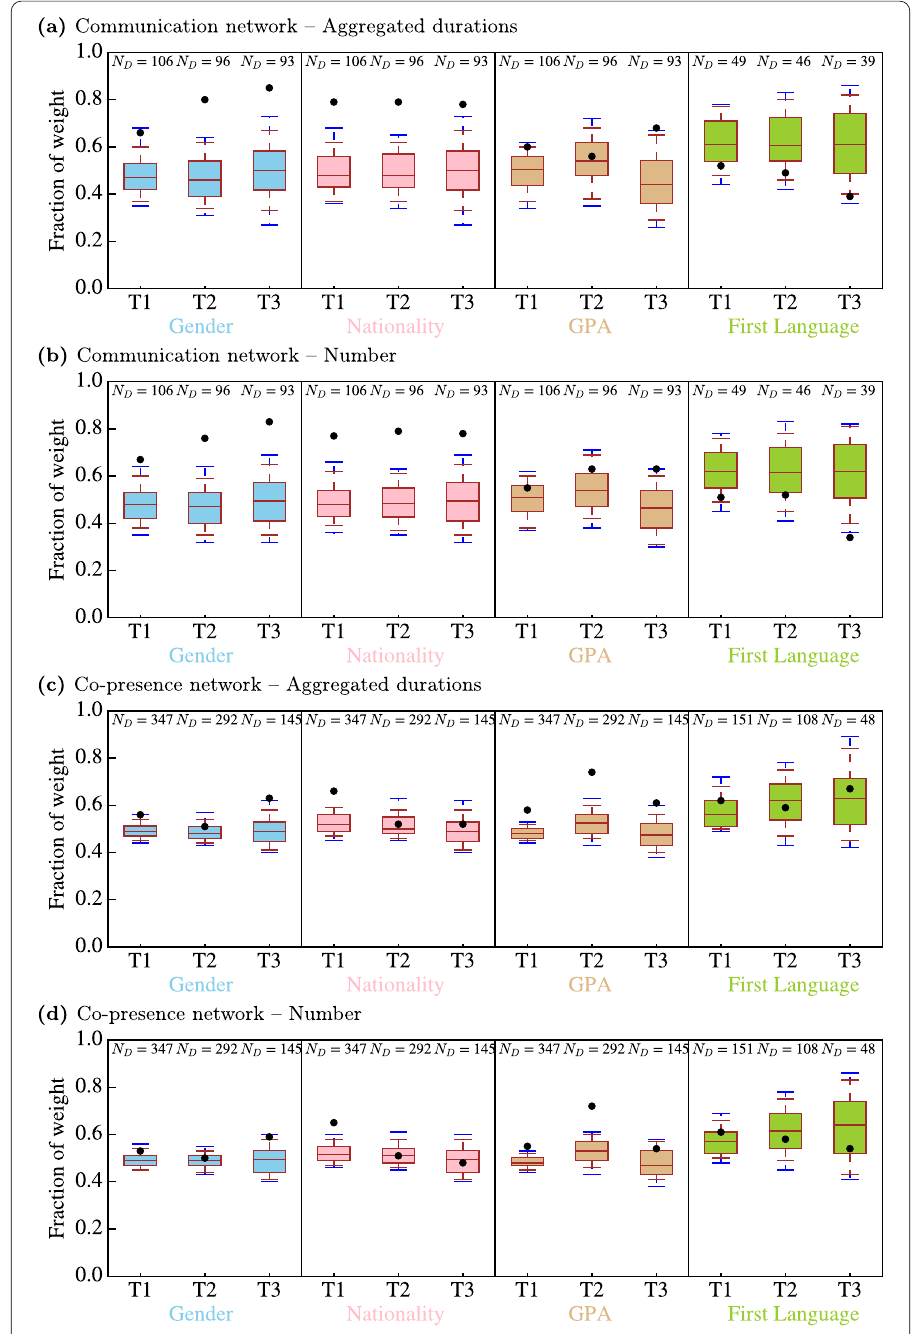
Figure 13 Homophily in dyads with respect to several attributes—term aggregated communication and co-presence networks. Data (black dots) are compared with the distribution (boxplots) obtained for a null model in which attributes are reshuffled among nodes. N D gives the number of dyads on which the measure is performed. Boxplot: Whiskers—5th, 10th and 90th, 95th percentiles; box—25th and 75th